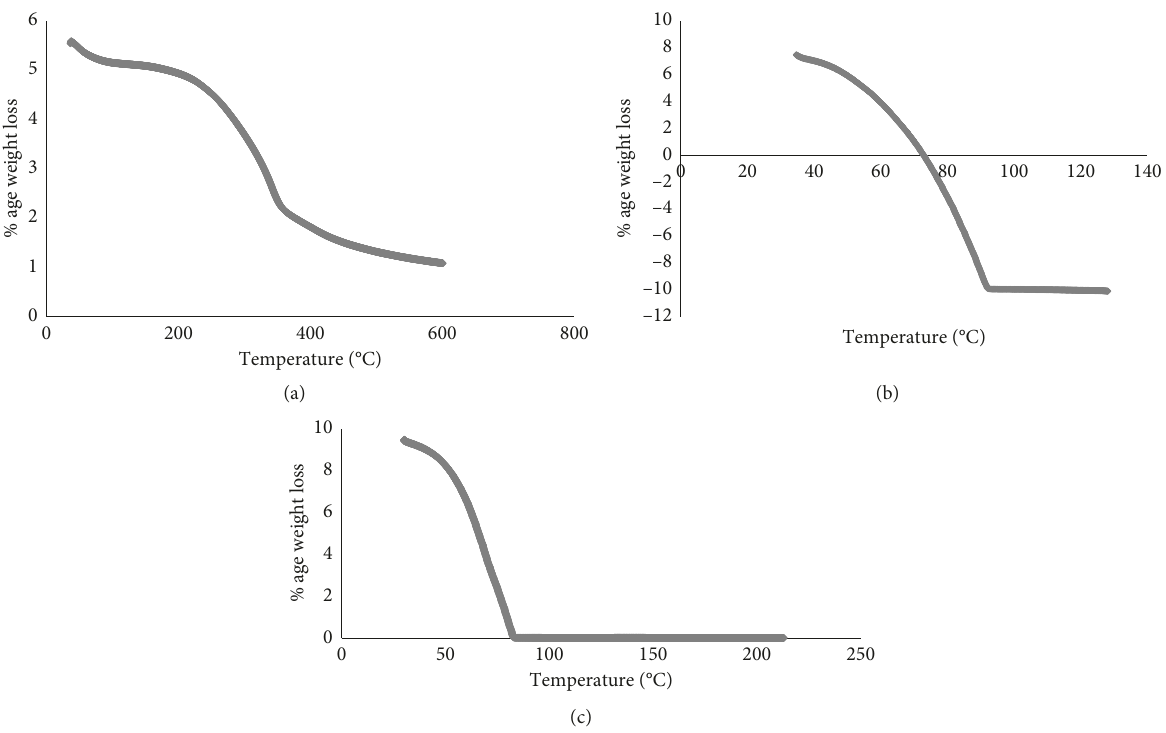
Figure 10: TGA curve for (a) untreated PR leaves, (b) brilliant green-treated PR leaves, and (c) acid orange-treated PR leaves.